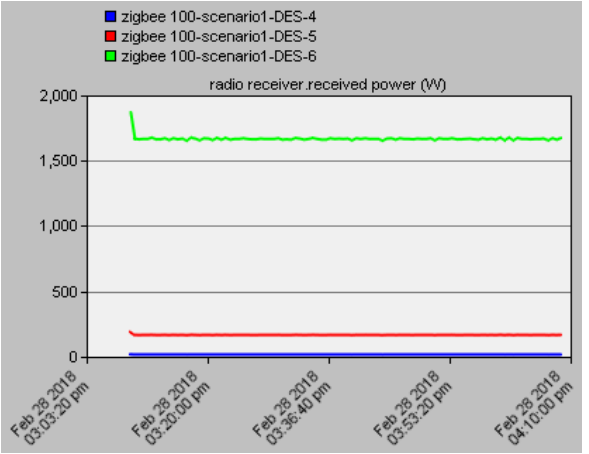
Figure 4. Fluctuations in Received Power for the second Value Group. (X axis: Time, Y axis: Received power).